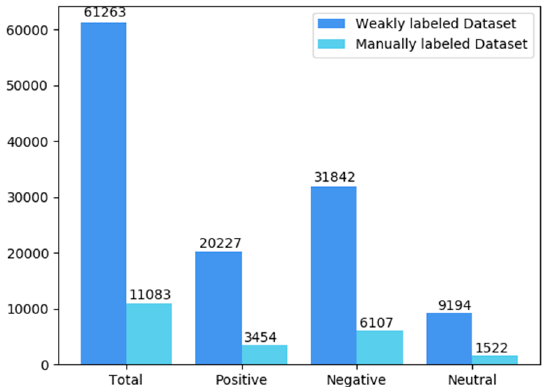
Figure 3. Sizes of the weakly labeled and manually labeled datasets. 258